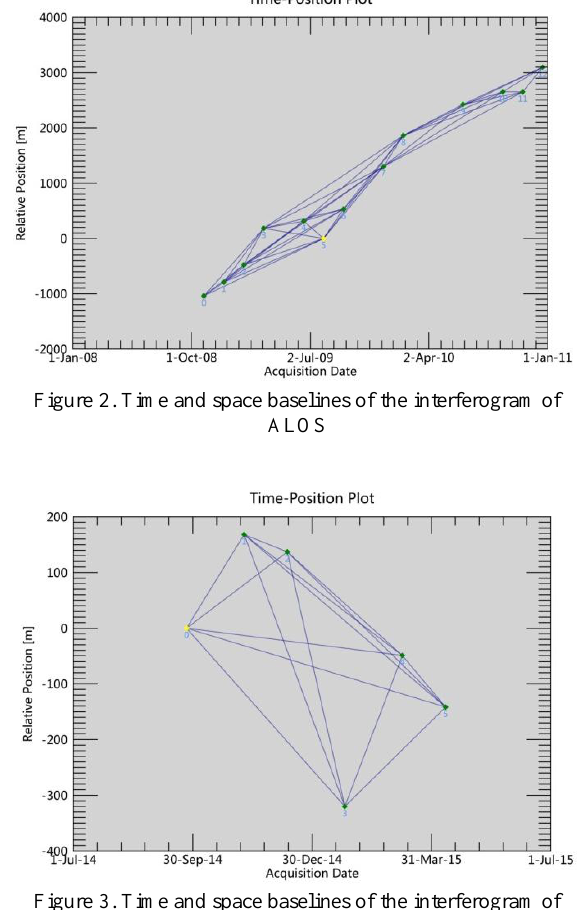
Figure 1. The extent of ALOS and TerraSAR-X